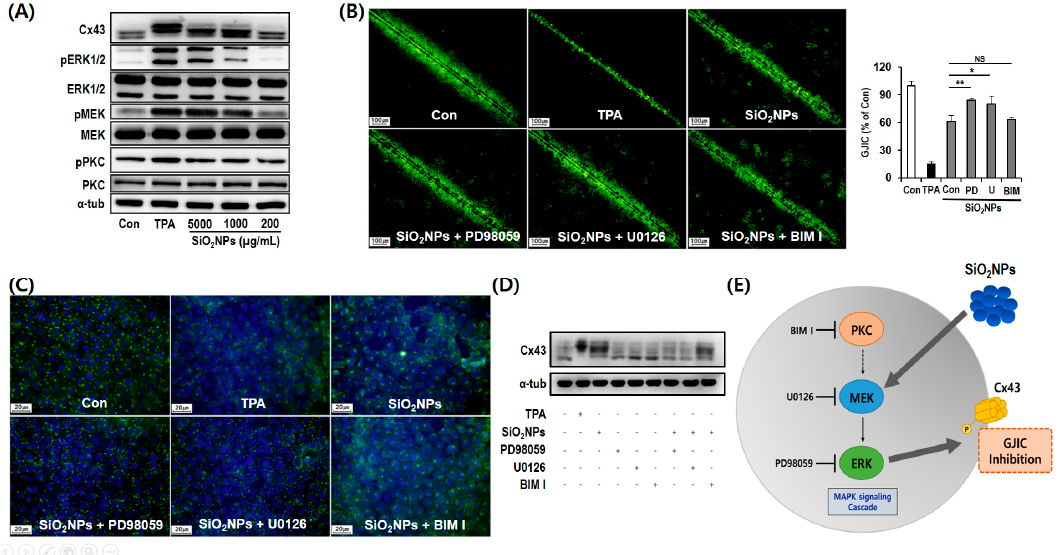
Figure 6. Effects of SiO 2 NPs on phosphorylation Cx43 in WB-F344 cells. ( A ) Effects of SiO 2 NPs on Cx43 phosphorylation and MAPK pathway activation in WB-F344 cells. Representative Western blot assay after the treatments with 200, 1000, or 5000 μ g/mL SiO 2 NPs and 10 ng/mL TPA for 12 h. ( B – D ) Effects of MAPKs pathway inhibitors on SiO 2 NP-induced GJIC inhibition in WB-F344 cells. The cells were pretreated with 50 μ M ERK inhibitor PD98059, 10 μ M MEK inhibitor U0126, and 10 μ M PKC inhibitor BIM I for 30 min before the treatment with 5000 μ g/mL SiO 2 NPs for 12 h. In total, 10 ng/mL TPA was treated as a positive control. ( B ) Representative images for SL/DT assay. NS, not significant. ( C ) Representative images for immunofluorescence staining. ( D ) Representative images for Western blot assay. ( E ) Schematic representation of the inhibition of GJIC by the SiO 2 NPs. Data expressed as means ± SD (* p < 0.05 and ** p < 0.01). Bar represents 1.0 mm.